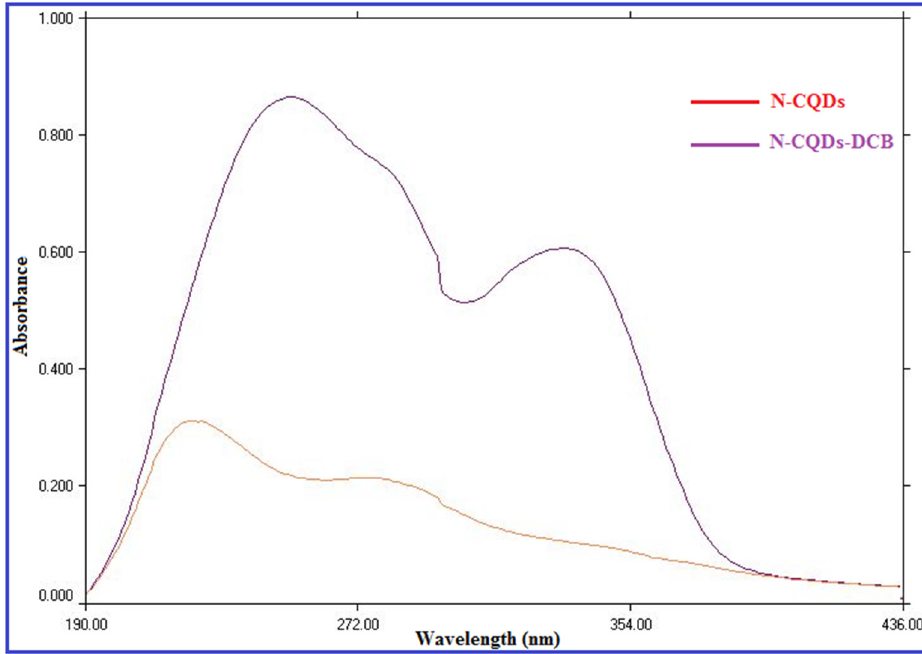
Figure 5. Effect of the addition of DCB on the UV absorption spectrum of N-CQDs.